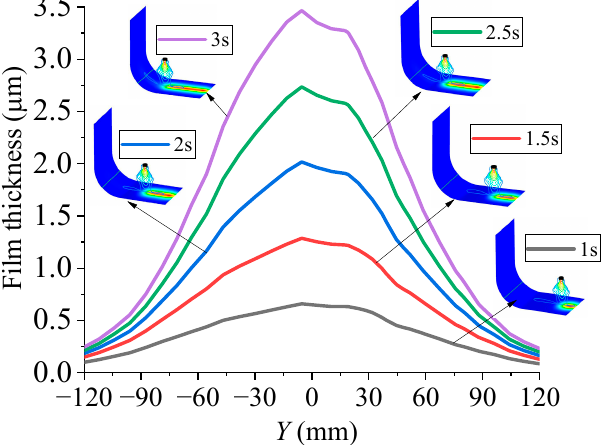
Figure 9. The film thickness distributions on a position of the 90-degree arc surface when the nozzle moves for 1 s, 1.5 s, 2 s, 2.5 s and 3 s.